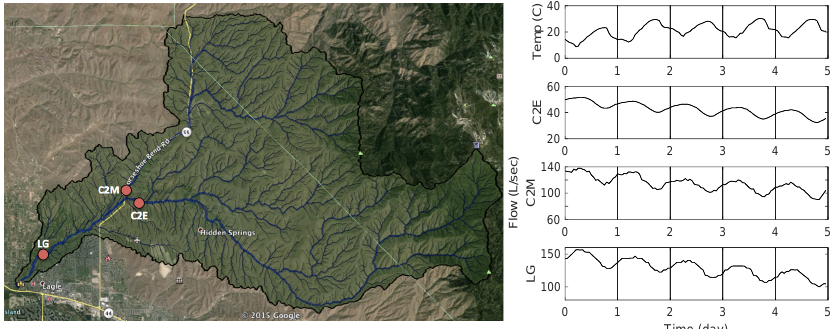
Figure 1. The left panel shows the Dry Creek watershed in Idaho. The right panel shows temperature (top), streamflow at gauge C2E near the center of the watershed (second), streamflow at gauge C2M (third), and streamflow at the outlet of the watershed (bottom). To demonstrate the delay in phases, a vertical line at the beginning of each day is included in each graph.